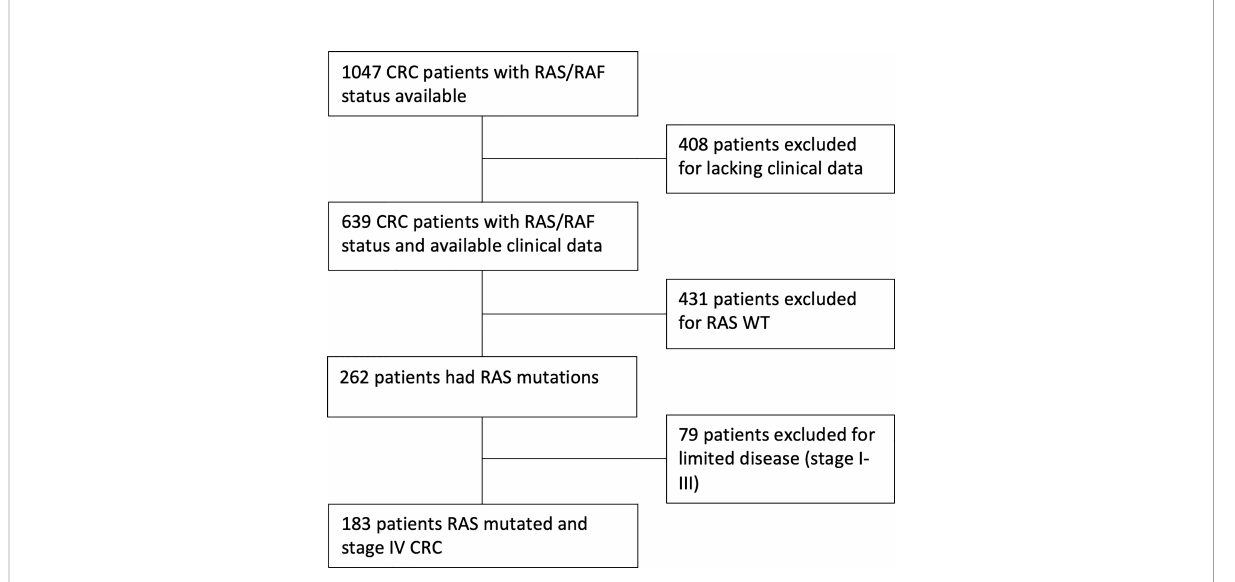
FIGURE 1 Flow chart of CRC patients with available RAS mutational status within the RAS&Co